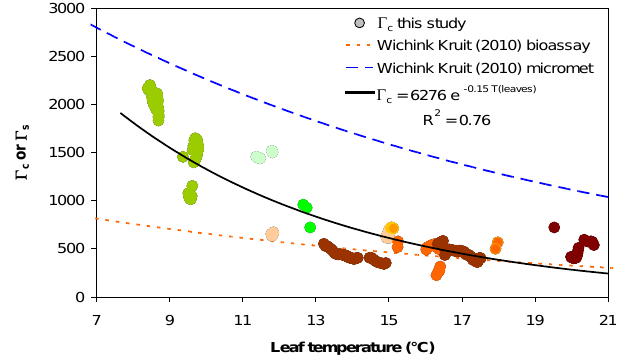
Fig. 10. 0 c as a function or leaf temperature (estimated with Sur- fatm NH 3 ) (rounds). Each color represent a weekly period (from week 18 in brown to week 27 in green) The solid black line is the fitted exponential function and the dotted lines are the modelled 0 s in Wichink et al. (2010) using either the micrometeorogical esti- mate (blue dotted line) or the bioassay estimate (orange dotted) of 0 s . The latter were estimated using the regression lines in Fig. 9 to retrieve 0 s , method , and equation (16) of Wichink et al. (2010) to express the dependency to leaf temperature ( 0 s = 0 s , method 4.7 × exp − 0 . 071 × Ts ). The 0 s , method were estimated based on the average NH 3 concentration during the experiment (were 260 for the bioassays and 890 for the micrometeorological